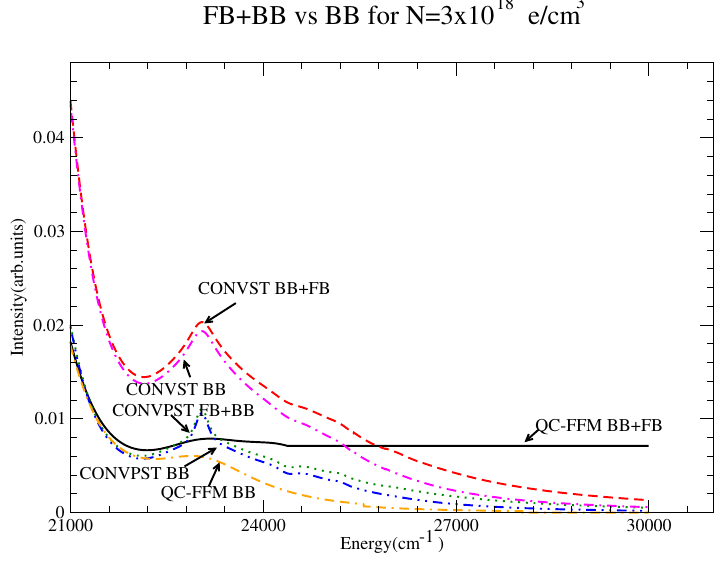
Figure 27. BB + FB vs. BB comparison for the highest density close to the continuum. Shown are QC-FFM for BB + FB (solid) and BB only (dot-double dashed), CONVST for BB + FB (dashed) and CONST for BB only (dash-dotted) and CONVPST for FB + BB (dotted) and BB only (dash-double dotted).